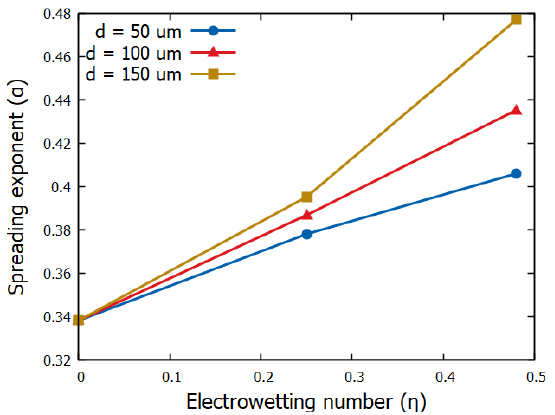
Figure 5. Spreading exponent, a , of the power-law, r s = Ct a , fitted on the results obtained by simulations for flat and smooth solid substrates with various thicknesses.